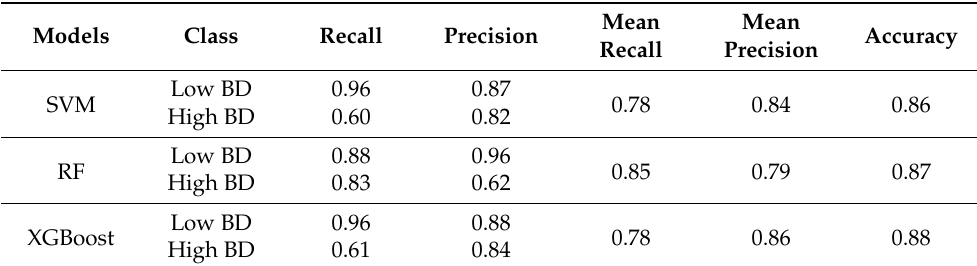
Table 2. SVM, RF, and XGboost models’ assessment results.